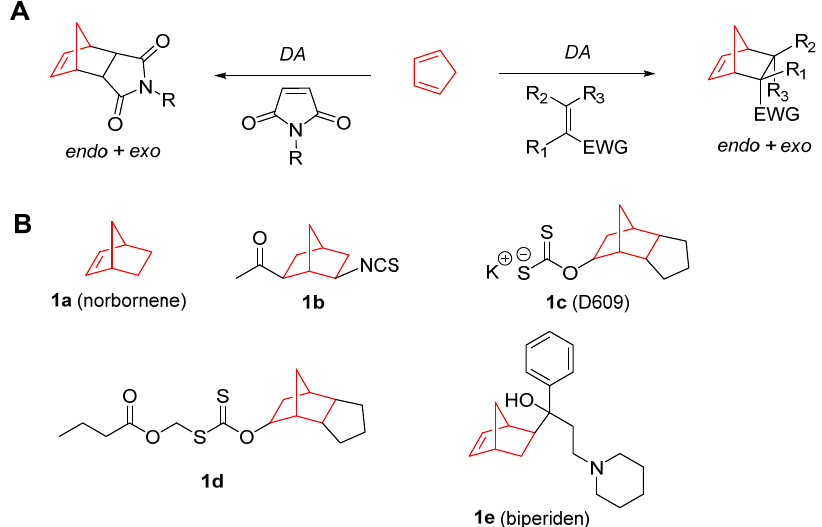
Figure 1. ( A ) Main synthetic routes for norbornene derivatives (EWG, electron ‐ withdrawing group). ( B ) Norbornene and several other derivatives with antitumoral properties [19–27].